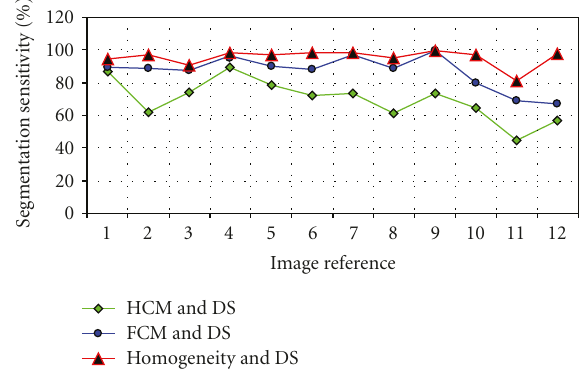
Figure 9: Segmentation sensitivity plots using HCM and DS, FCM and DS and homogeneity method and DS for the data set shown in Figure